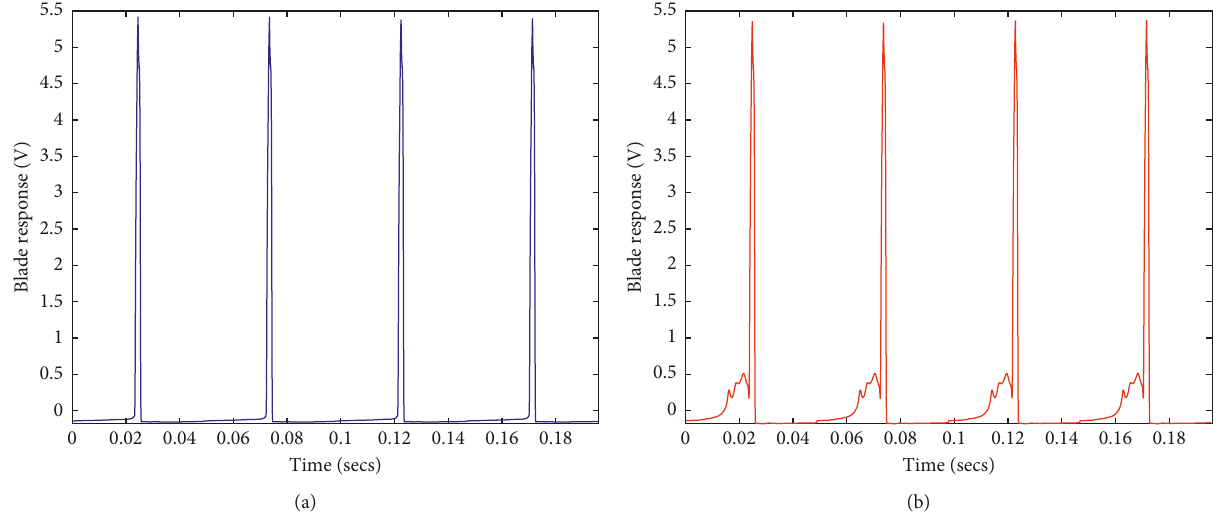
Figure 15: Optical sensor reconstructed BTT signals of blade 8 for a speed of 100rpm. (a) Undamaged and (b) damaged cases.